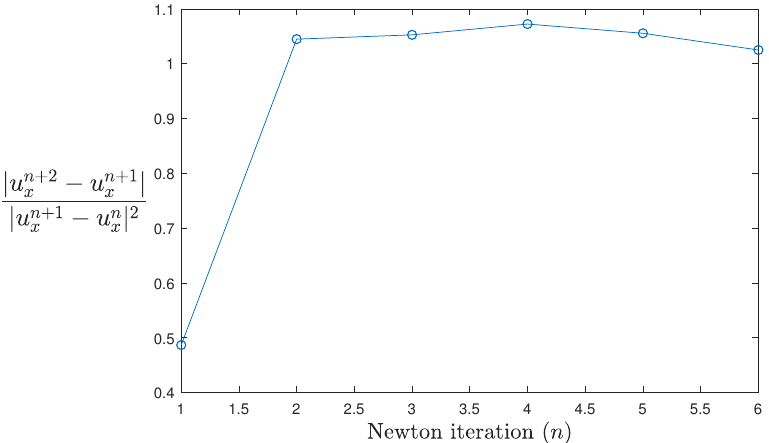
Figure 22. Ratio of the convergence of the Newton’s method for R = 1300, Γ = 3.495, np = 1, mp = 1, N × M = 50 ×